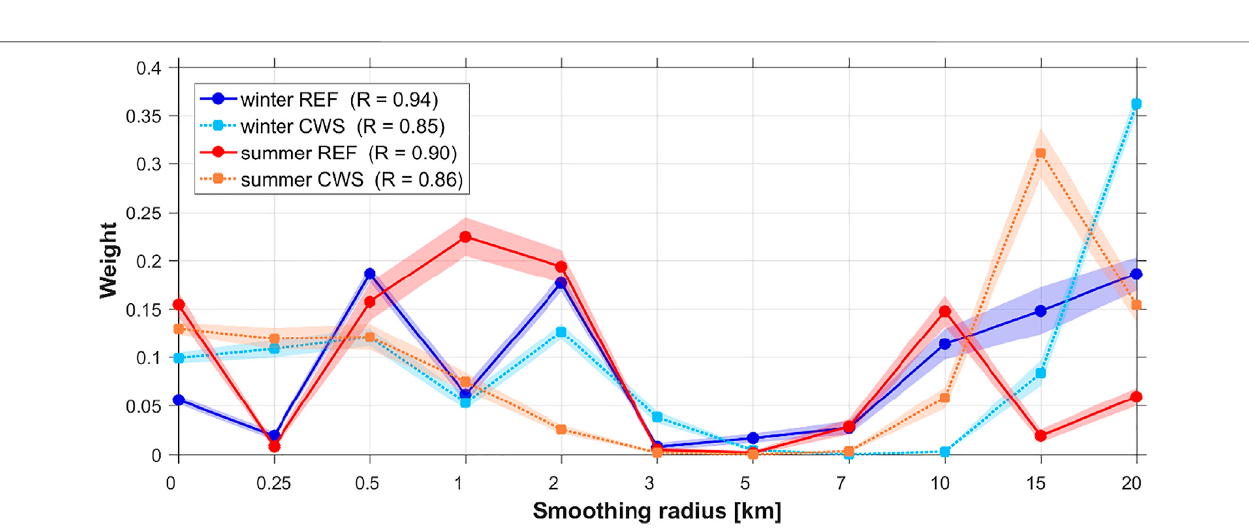
FIGURE10| Meanrelativeweightsofpredictors,smoothedwithdifferentradii,inthemulti-scaleMLRmodel,averagedoverbest25%ofpredictorcombinationsin randomly generated ensemble. R in the legend denotes mean regression coef fi cient over best 25% of predictor combinations.